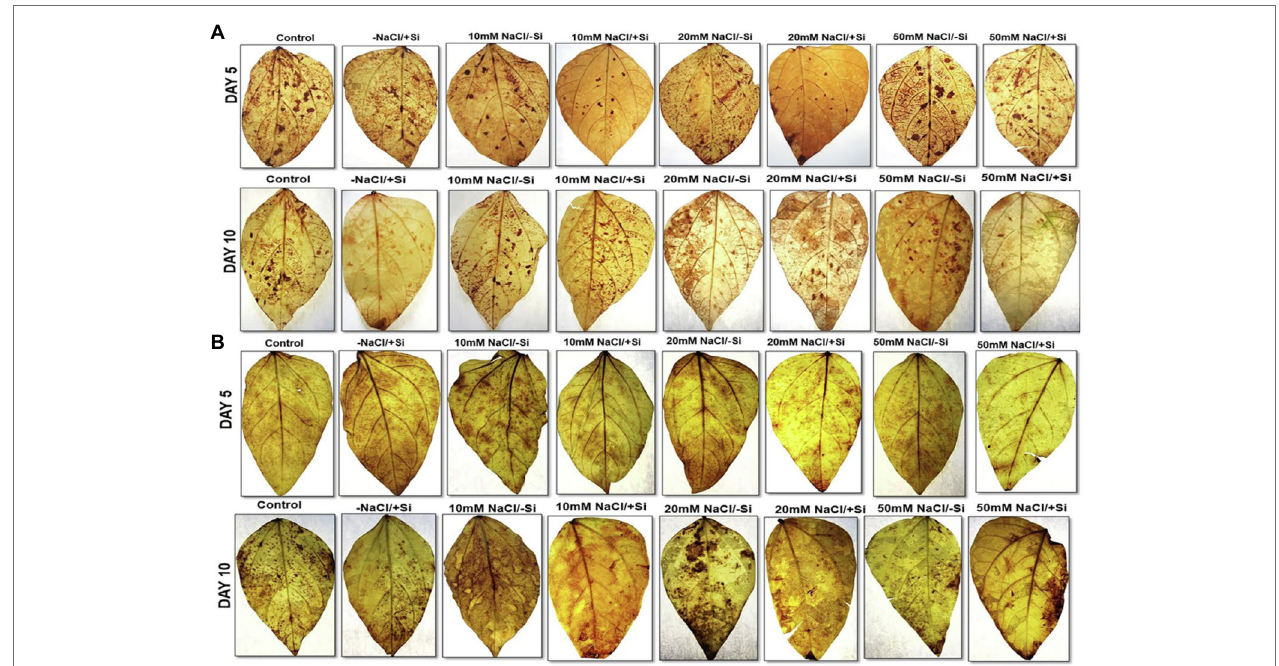
FIGURE 11 | Histochemical localization of H 2 O 2 in mung bean ( Vigna radiata ) under (A) 1 mM (Si 1 ) and (B) 5 mM (Si 2 ) Si supply and salinity stress after eight treatments: (i) control (T1), (ii) − NaCl+Si (1 mM/5 mM) (T2), (iii) 10 mM NaCl/ − Si (T3), (iv) 10 mM NaCl/+Si (1 MM/5 mM) (T4), (v) 20 mM NaCl/ − Si (T5), (vi) 20 mM NaCl/+Si (1 mM/5 mM) (T6), (vii) 50 mM NaCl/ − Si (T7), and (viii) 50 mM NaCl/+Si (1 mM/5 mM) (T8) for a period of 5 and 10